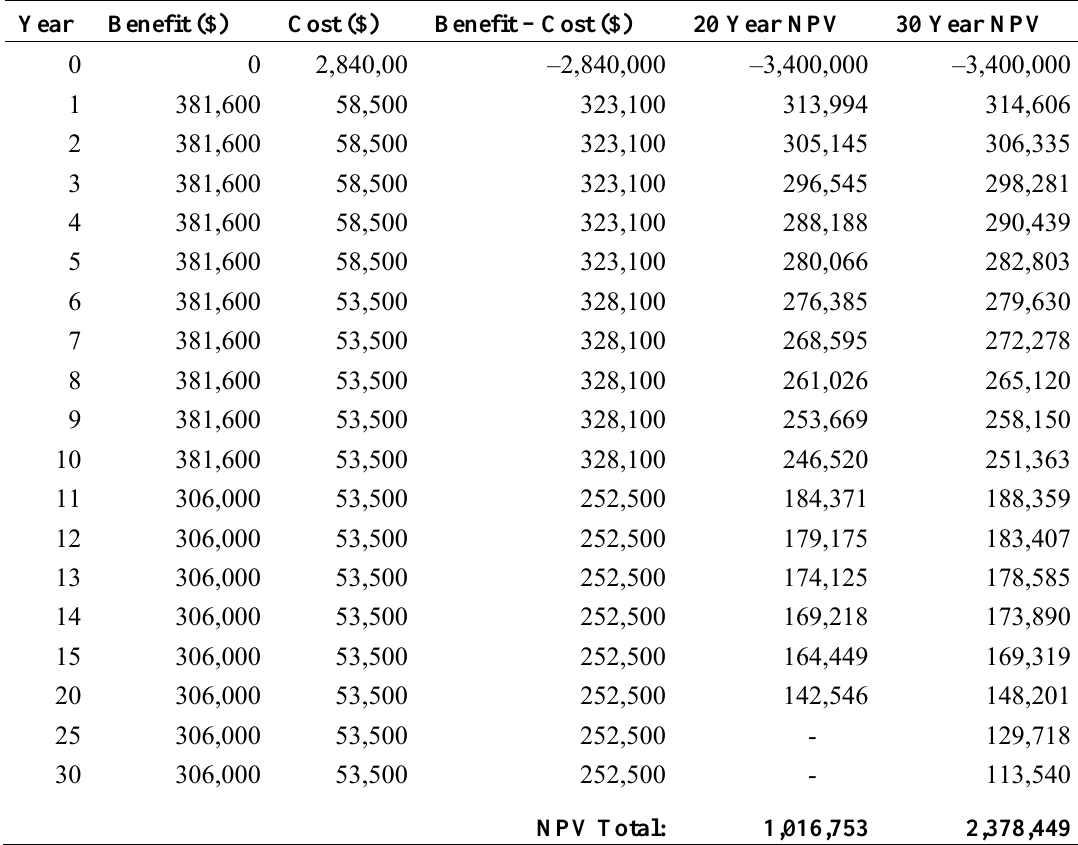
Table 3. The annual results of the base